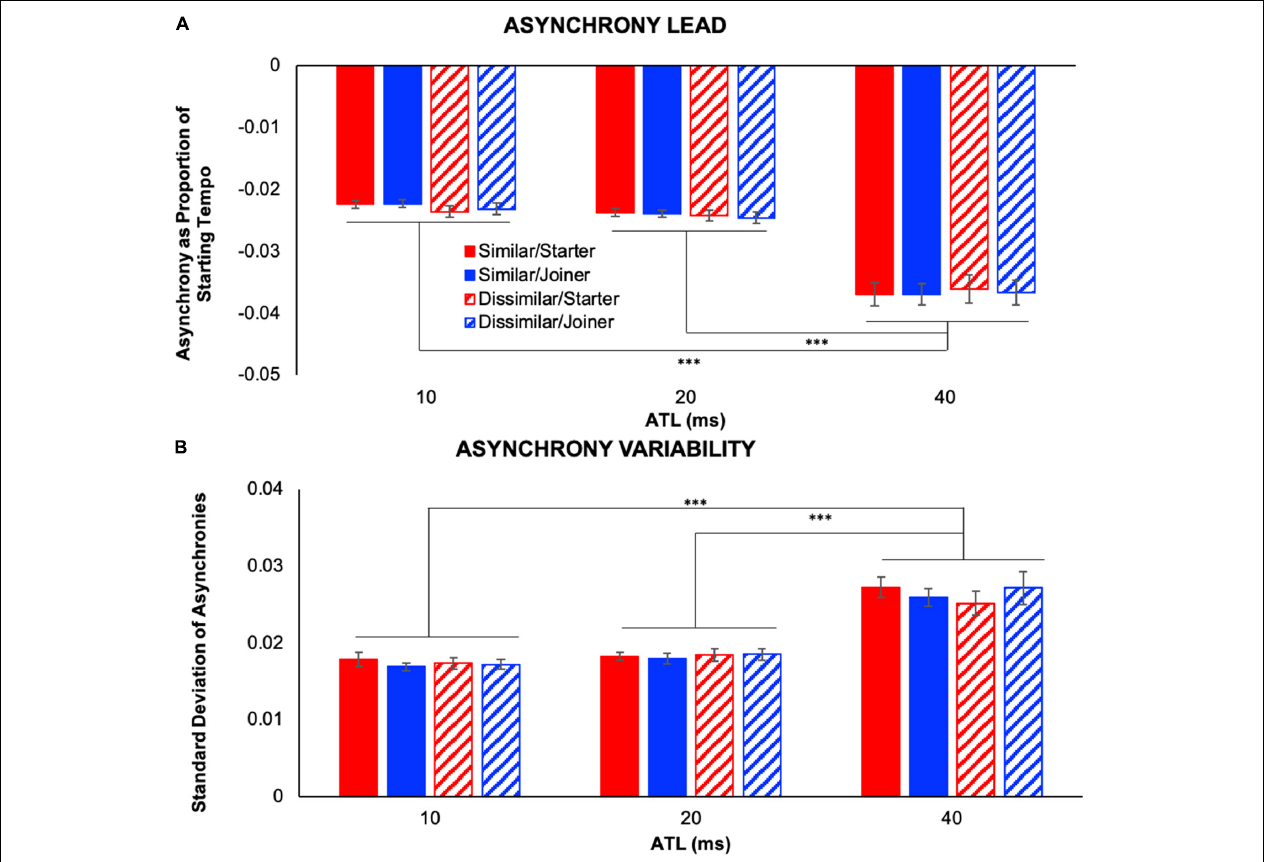
FIGURE 4 | Note asynchrony between partners. (A) Asynchrony lead indicates the magnitude of temporal lead exhibited when the performer played first at unison note positions. (B) Asynchrony variability illustrates the standard deviation of asynchrony lead that occurred at unison note positions. Both measures were significantly greater in the 40 ms ATL condition than in either of the other two ATL conditions. Error bars show standard error. ∗∗∗ p <